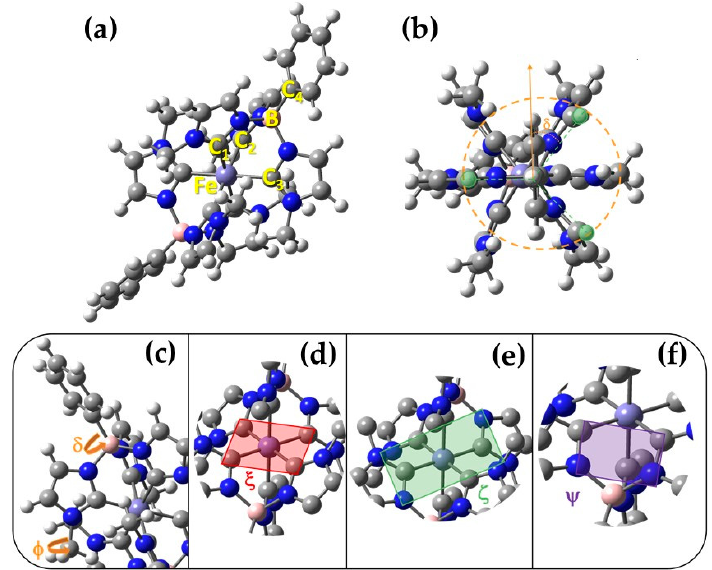
Figure 2. ( a ) DFT optimized GS structure of the iron complex in acetonitrile. Carbon, nitrogen, hydrogen, boron and iron atoms are displayed with gray, blue, white, pink and violet spheres, respectively and the atom labeling used in Table 1 is also reported; ( b ) Top view of the GS structure with a scheme showing the origin of the 60° periodicity of the δ torsional profile shown in Figure S1, with the imidazole hydrogens evidenced in green. Dihedral definition in the investigated iron complex: ( c ) flexible dihedrals δ and ϕ , ruling the rotation of the phenyl and methyl pendants, respectively; ( d ) stiff dihedral ξ , governing the coplanarity of four carbon atoms connected to the metal. ξ ’ and ξ ’’ can be defined exploiting the other two carbon quadruplets; ( e ) stiff dihedral ζ ,